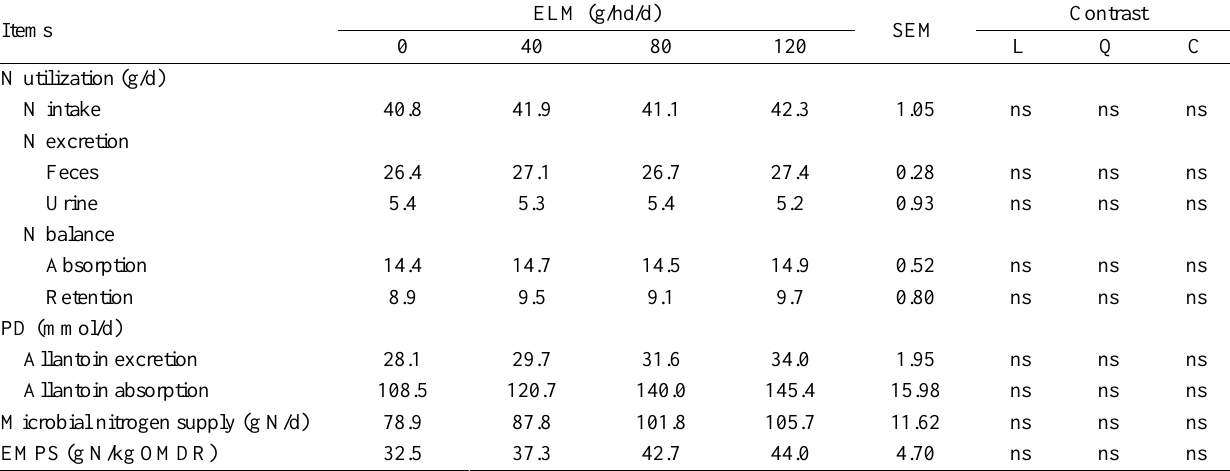
Table 5. Effects of Eucalyptus leaf meal supplementation on nitrogen metabolism and microbial protein synthesis